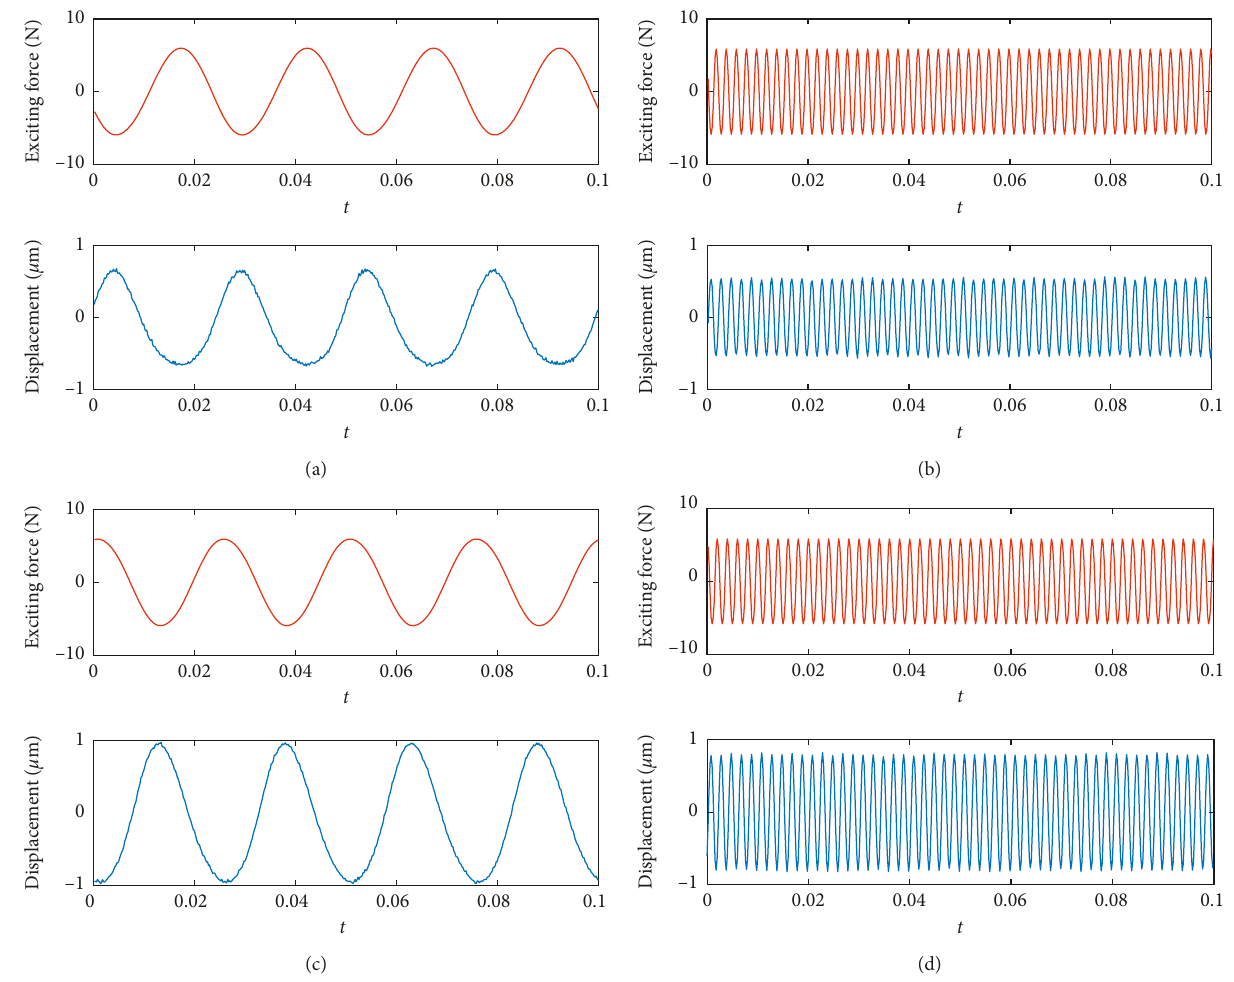
Figure 6: Dynamic gas film force and dynamic displacement under different perturbation frequencies: (a) ω � 40Hz; (b) ω � 500Hz; (c) ω � 40Hz; (d) ω �